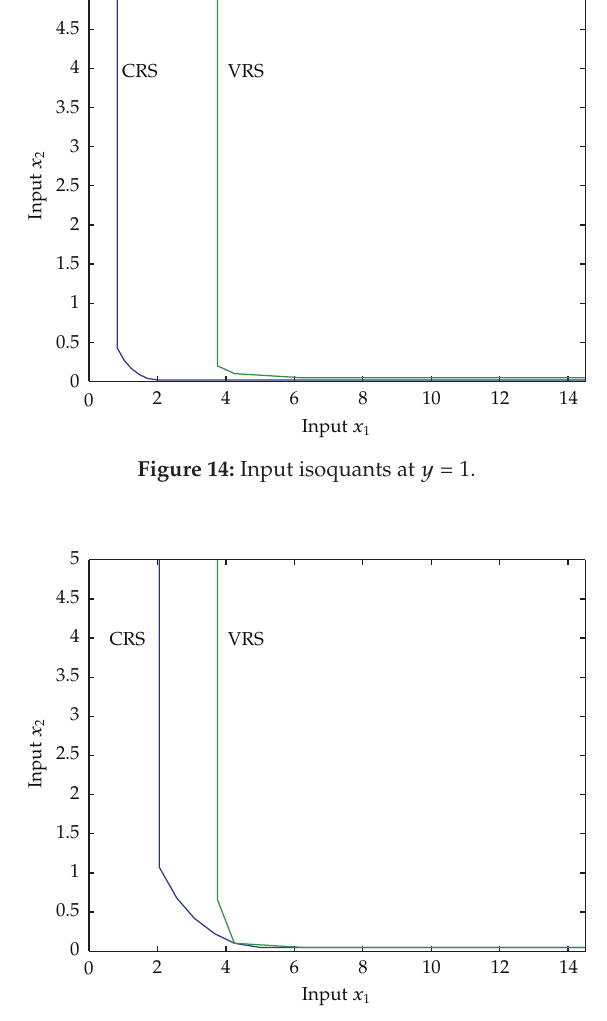
Figure 15: Input isoquants at y (cid:9) 2 ,